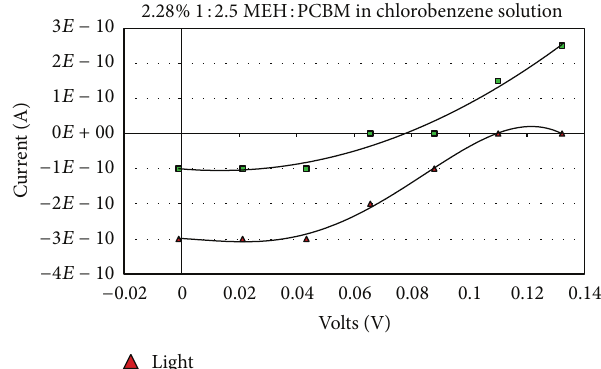
Figure 7: 𝐽 - 𝑉 curve measured for MEH-PPV:PCBM nanofibers on coplanar bimetallic interdigitated electrode. Red triangles are the device response with AM1.5 illumination of 80mW/cm 2 , and green squares show the response with the device placed in the dark. The curves are polynomial fits to guide the